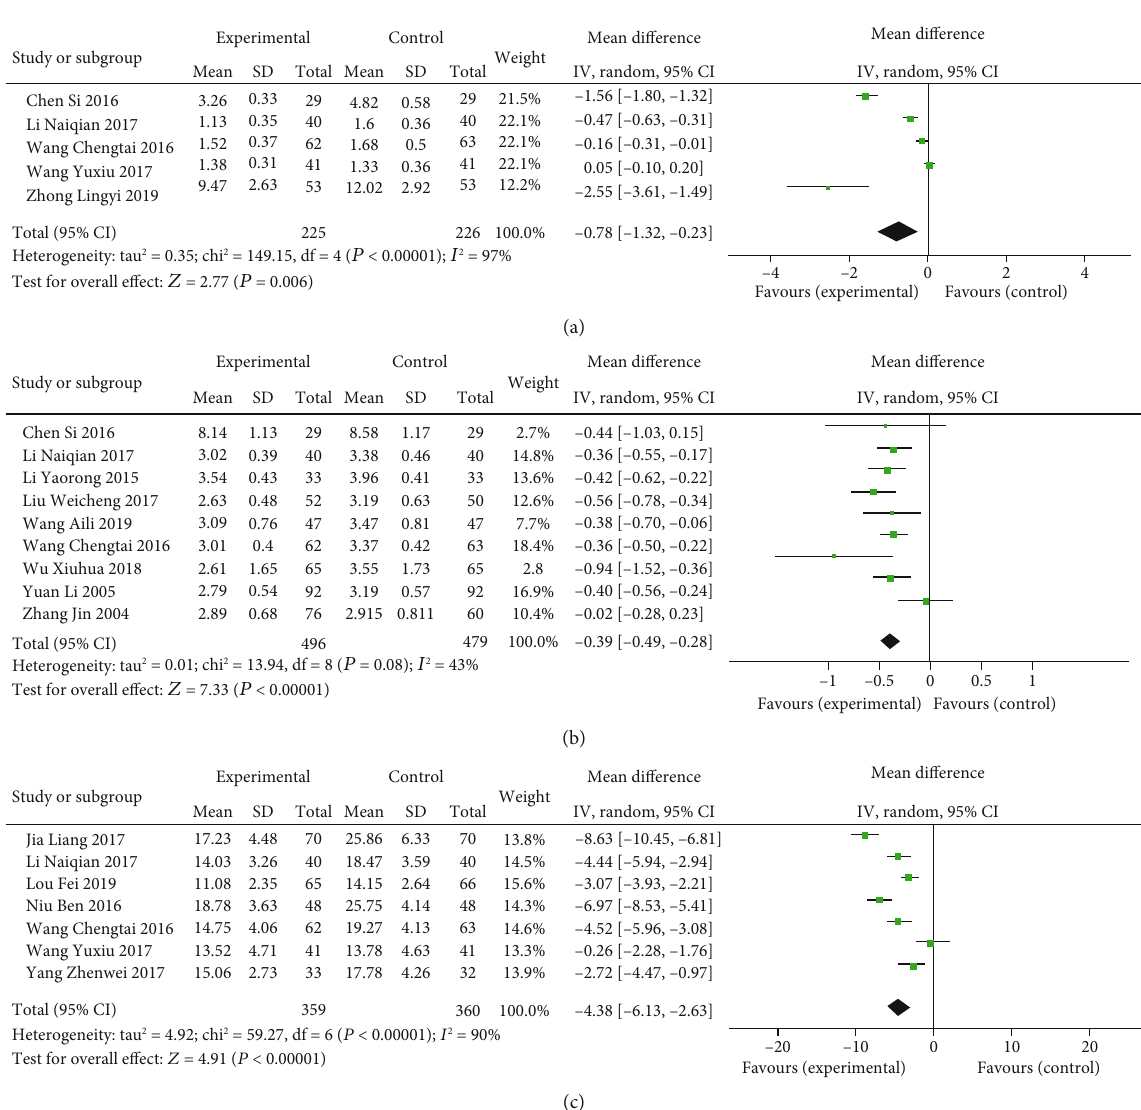
Figure 6: Forest plot of indices of hs-CRP, FIB, and HCY function in patients treated with TCMs and routine treatment. (a) The plot of hs- CRP, (b) the plot of FIB, and (c) the plot of